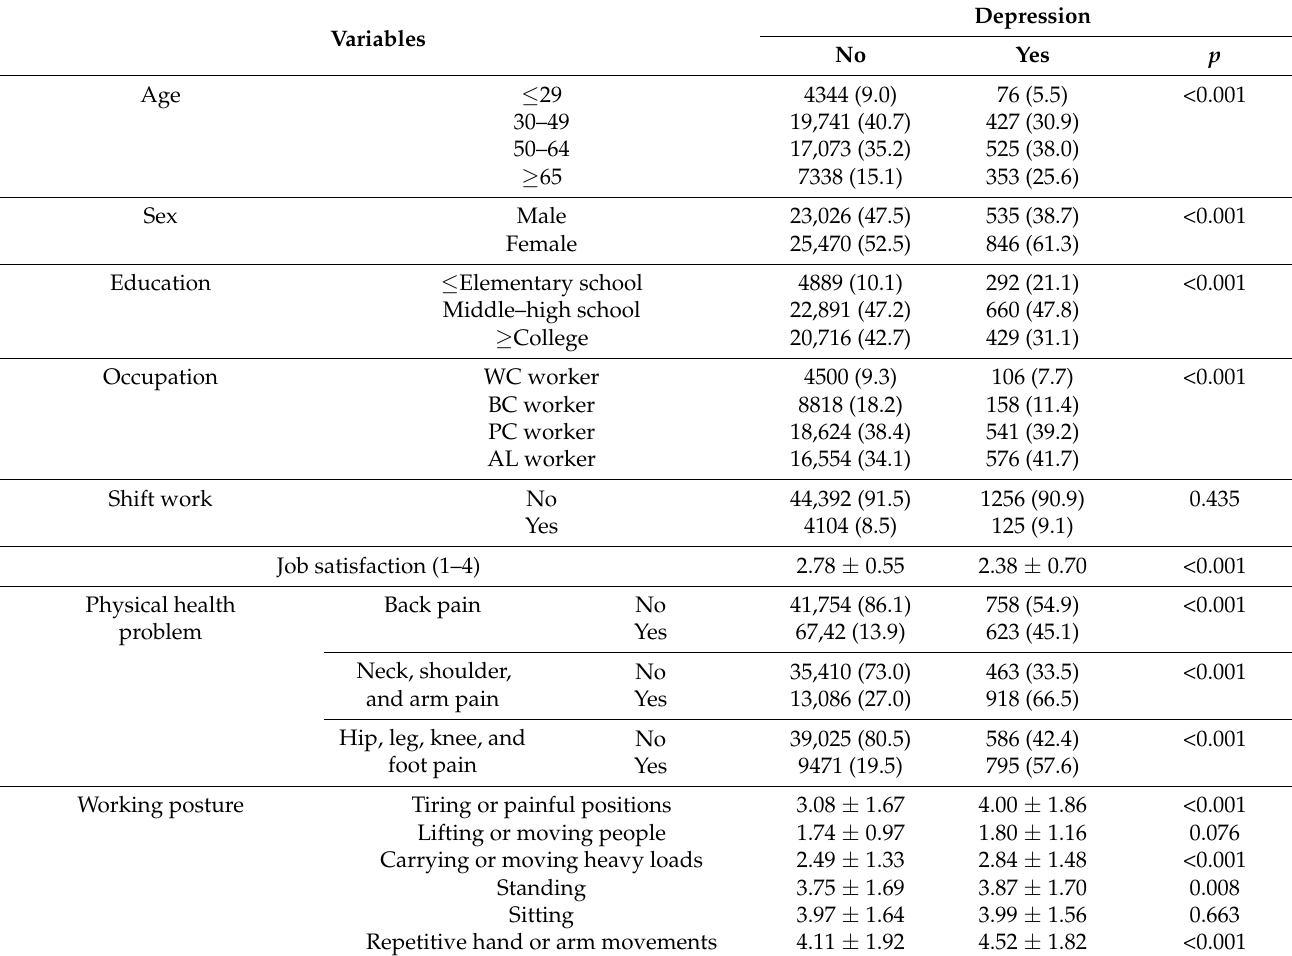
Table 1. General characteristics of workers ( n =